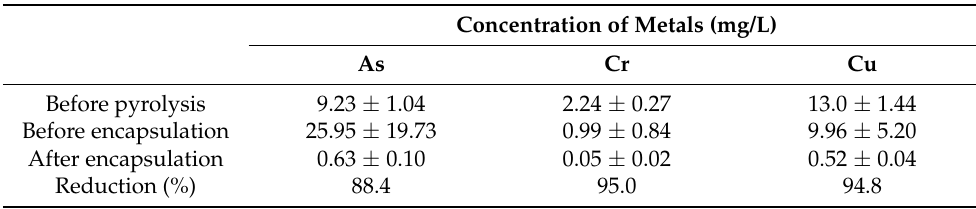
Table 5. Average metal concentrations in biochar leaching solutions before pyrolysis and before and after encapsulation, according to the TCLP